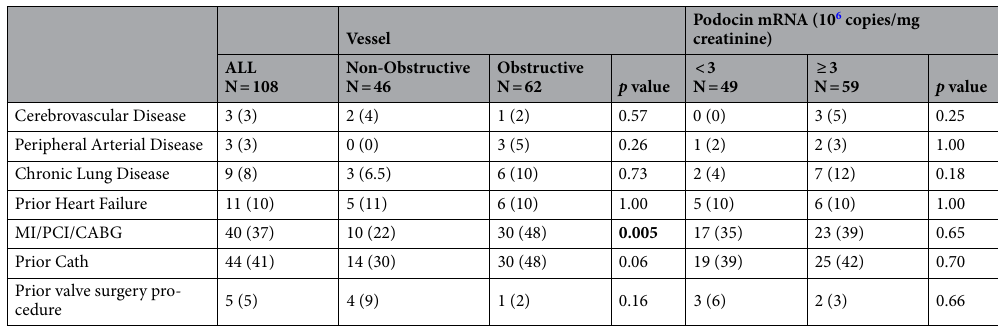
Table 3. Demographical and characteristic summary of the study sample based on obstructive coronary artery disease and podocin mRNA. Significant values are in bold.